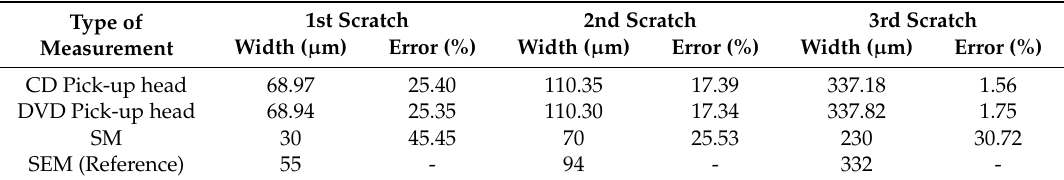
Table 2. Comparisons of width measurements and percentage errors of 3 scratches measured by CD, DVD, SM, and SEM.